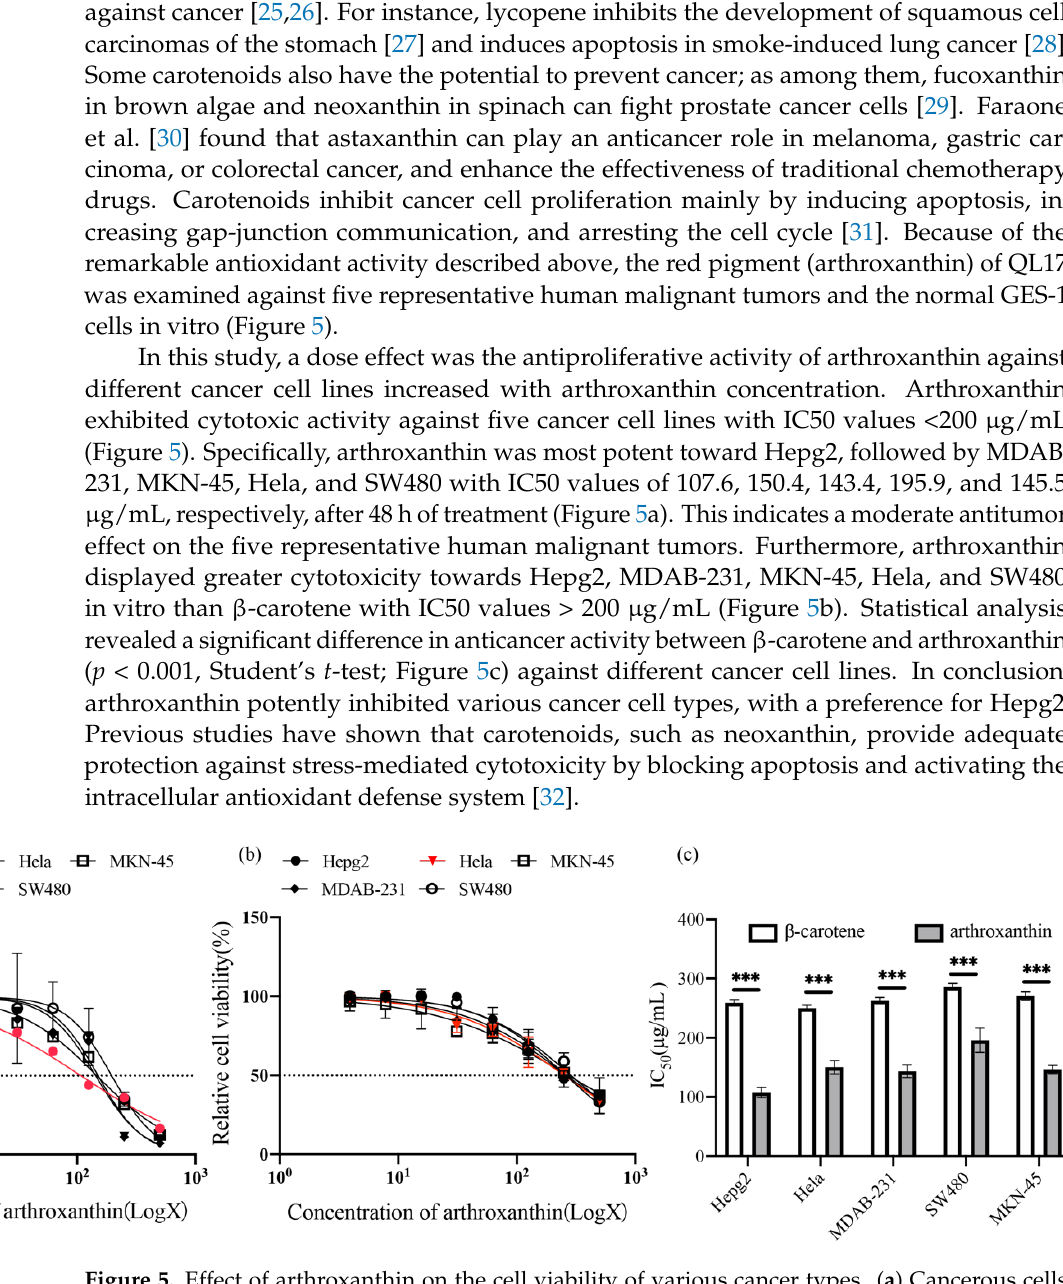
Figure 5. Effect of arthroxanthin on the cell viability of various cancer types. ( a ) Cancerous cells were incubated with different concentrations of arthroxanthin (0 – 500 µg/mL) for 48 h. Then, cell viability (%) was assessed by an MTT assay. ( b ) Cancerous cells were incubated with different con- centrations of β -carotene (0 – 500 µg/mL) for 48 h. ( c ) IC 50 valu es of β -carotene and arthroxanthin against cancerous cells at 48 h. *** p < 0.001 compared with β